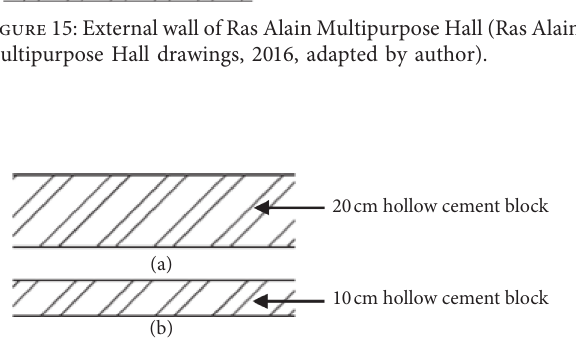
Figure 16: Internal walls of Ras Alain Multipurpose Hall (Ras Alain Multipurpose Hall Drawings, 2016, adapted by